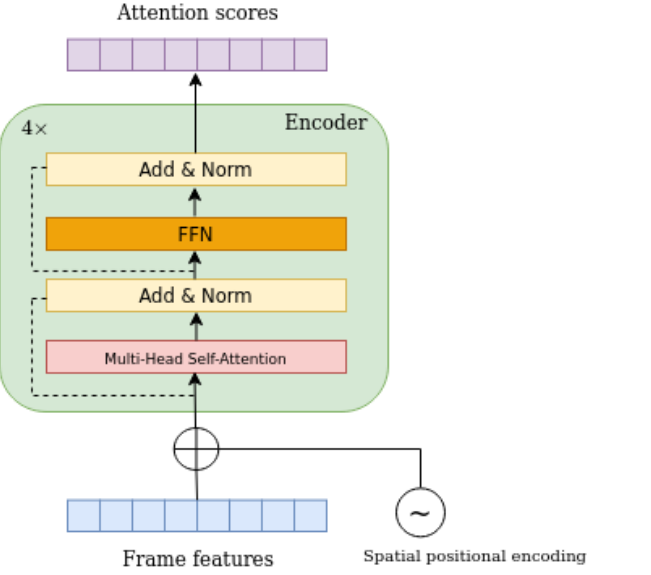
Figure 4. In this figure, the encoder layer architecture is depicted. The encoder of the model consists of four identical, consecutive layers.